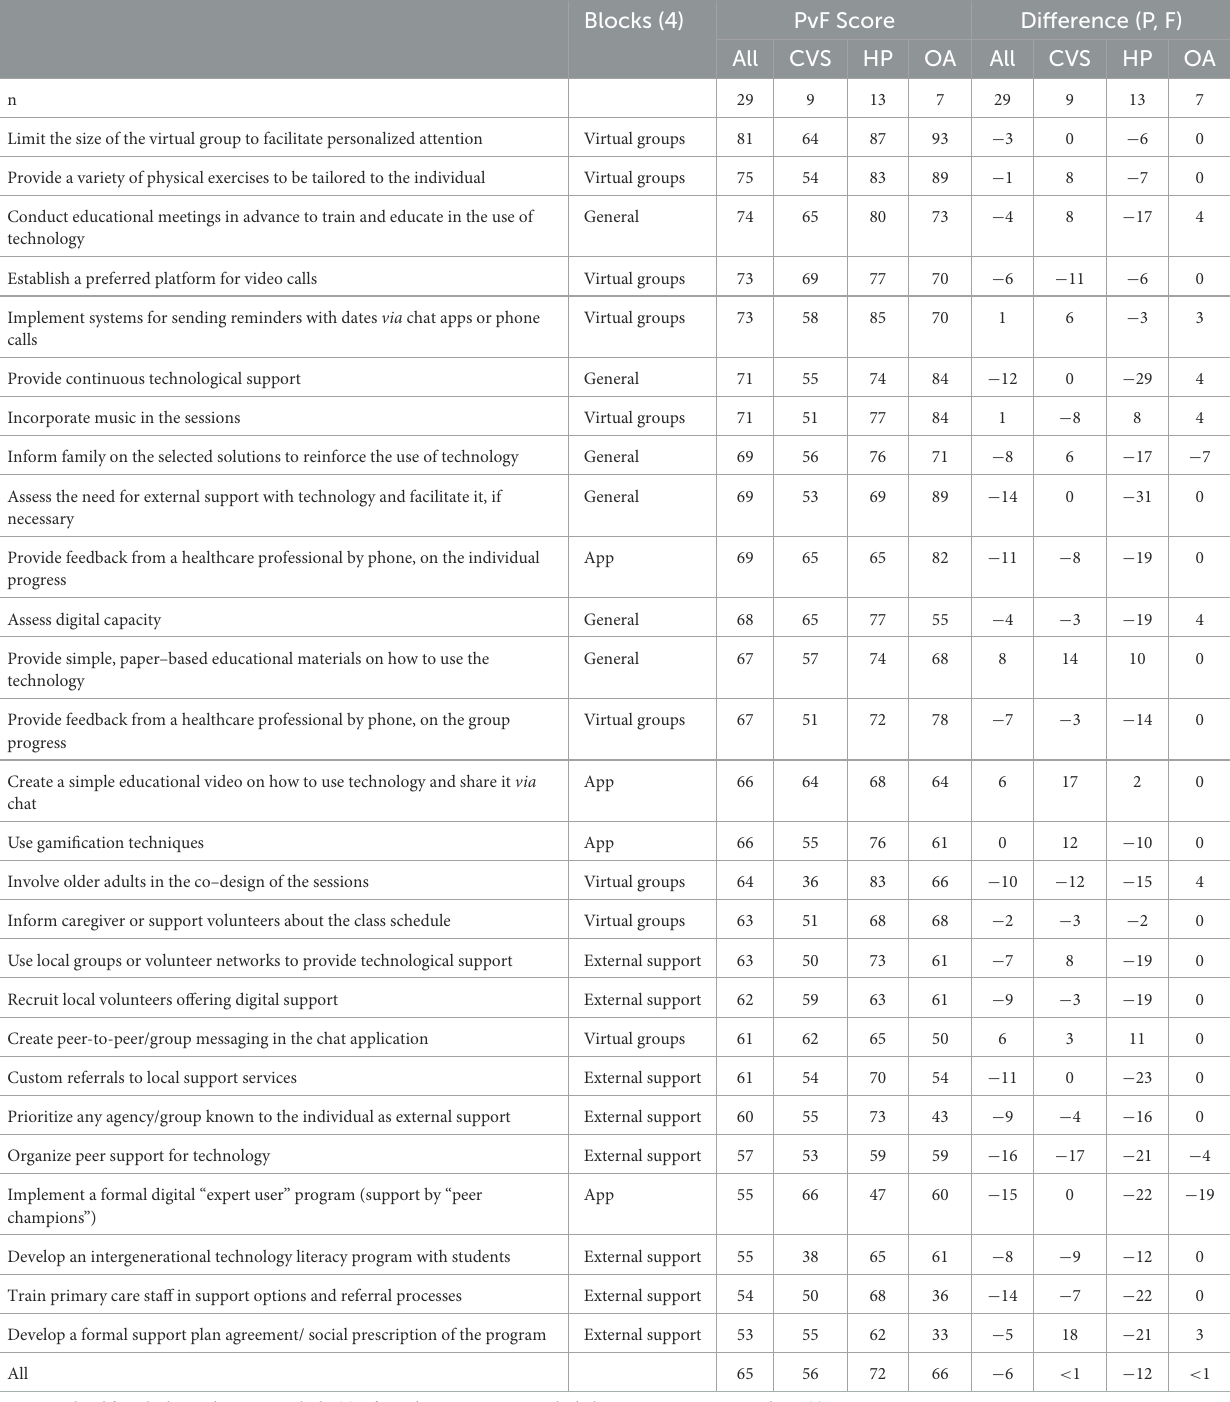
TABLE 3 Comparison of priority (P) vs. feasibility (F) score (PvF) for each suggested strategy, and differences between average P and F for each item of the